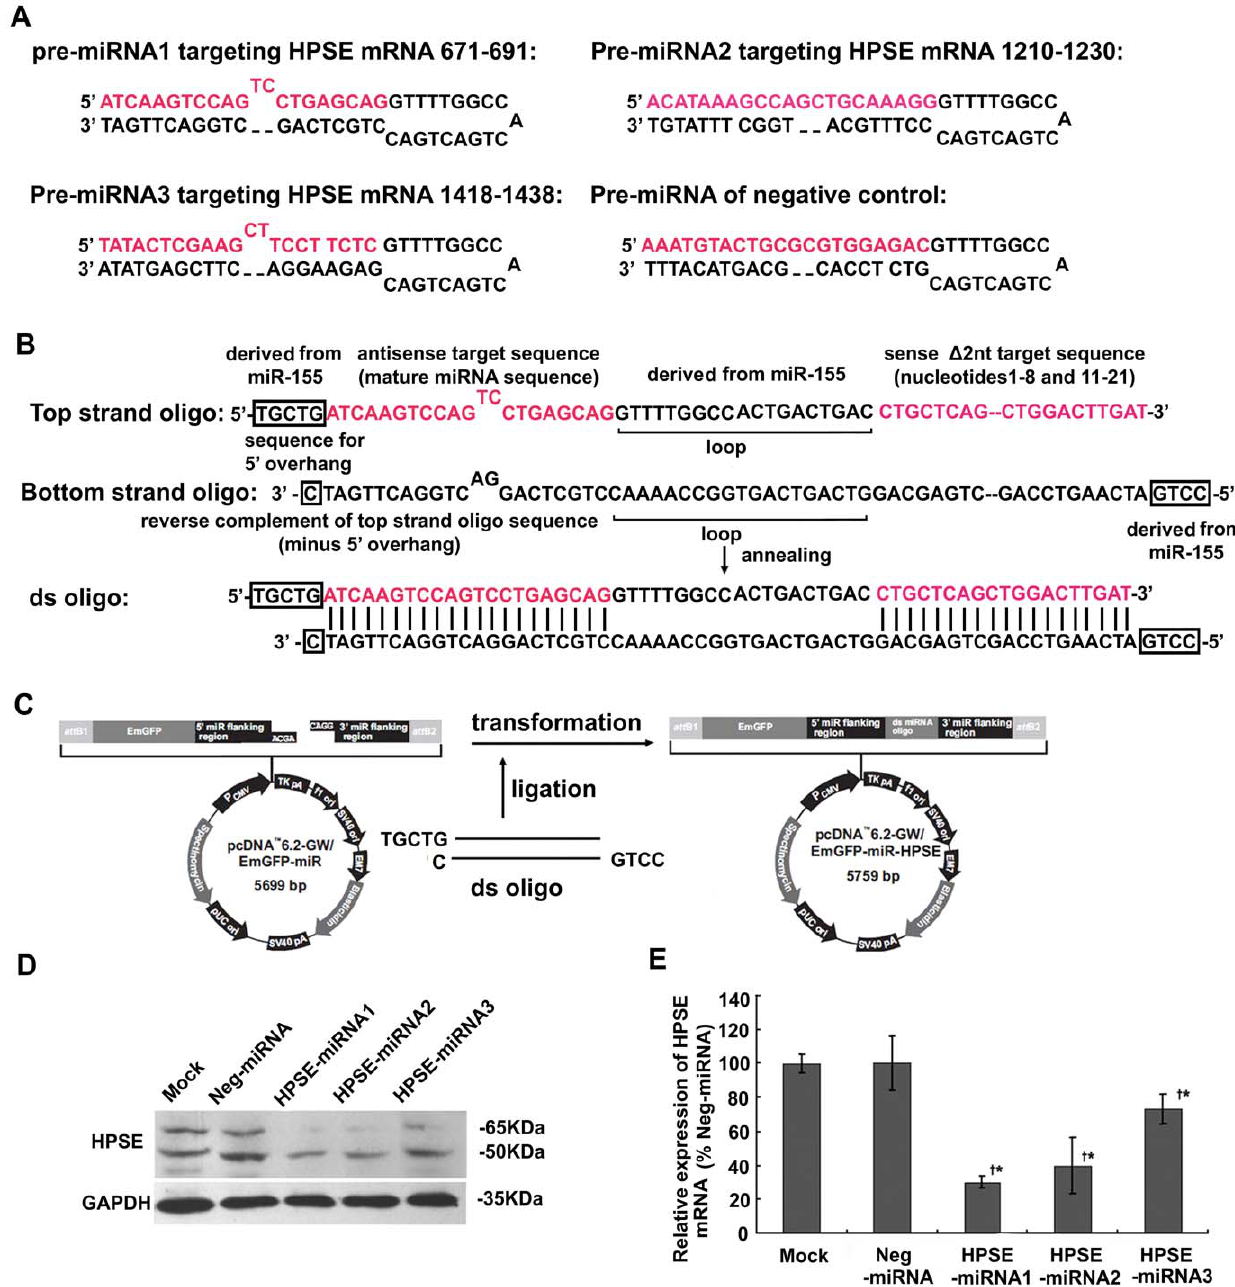
Figure 1. Construction of of miR-155-based HPSE miRNAs and their impact on HPSE expression levels in A375 cells. A375 cells were transfected with HPSE-miRNAs or Neg-miRNA for 48 hours. (A) The sequences and predicted secondary structures of three designed pre-miRNAs targeting HPSE (HPSE-miRNA1, HPSE-miRNA2, and HPSE-miRNA3) and a negative control miRNA (Neg-miRNA), and the precise regions of the HPSE mRNA that they targeted. (B) Pre-miRNA double-stranded oligo inserted into the miRNA expression vector-pcDNA6.2-GW/EmGFP-miR. (C) Schematic representation of the process of ligation and transformation. (D) Inhibitory effects of HPSE miRNAs on HPSE protein expression. Representative blots are shown from three independent experiments with identical results. The expressions of HPSE protein in A375 cells transfected with HPSE miRNAs were obviously down-regulated obviously compared to the parental cells and the Neg-miRNA group. (E) Inhibitory effects of HPSE miRNAs on HPSE mRNA expression. Calculation of the respective HPSE mRNA expression in each group was relative to the Neg-miRNA group (%). Quantitative real- time PCR results showed that the expression of HPSE mRNA in A375 cells transfected with HPSE miRNAs were down-regulated compared to the parental cells or the Neg-miRNA transfected cells. ( { P , 0.05, compared with the parental cells; * P , 0.05, compared with the Neg-miRNA transfected cells).